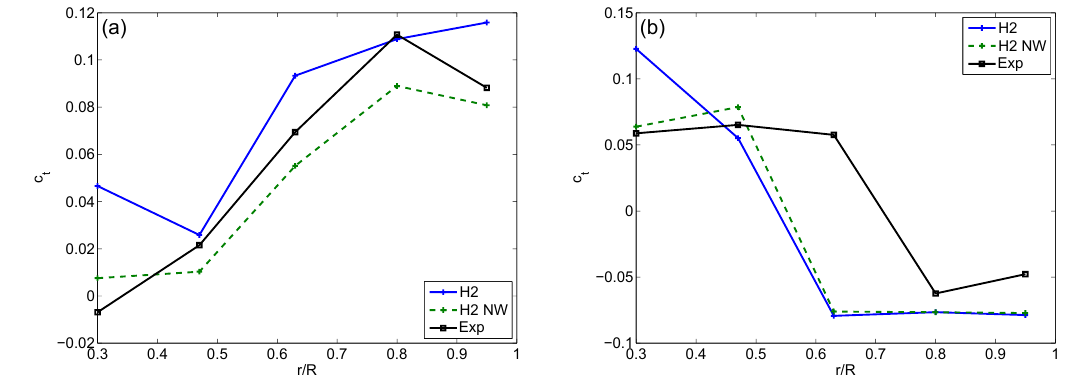
Figure 5. Radial distribution of tangential force coefficients at 3.5 (a) and 18.2 (b) degrees geometric AOA at 47% blade radius. Results from HAWC2 (denoted H2) and HAWC2 including the extended near-wake model presented in this paper (H2 NW) are compared to measurements.